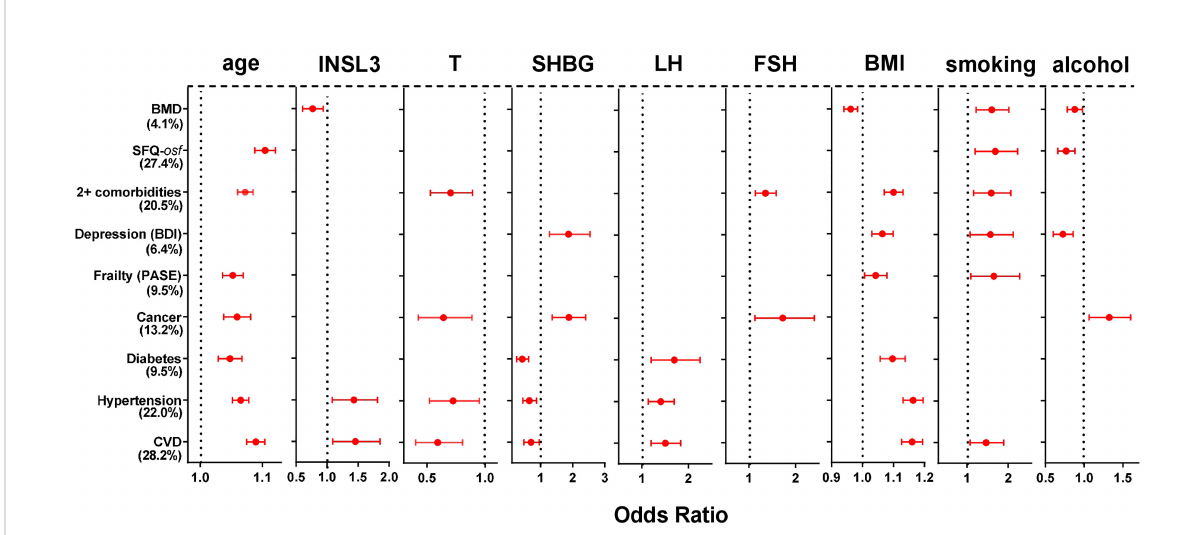
FIGURE 3 Signi fi cant Odds Ratios (OR; mean and 95% con fi dence intervals) calculated from multivariate binomial logistic regressions of the indicated binomial categorical variables from phase 2 representing different morbidities, as indicated on the Y axis, against various hormonal, anthropometric and lifestyle parameters as independent continuous predictors, as indicated, also from phase 2. Signi fi cant OR are indicated in red; non-signi fi cant relationships are excluded (not shown). The estimated variance (percentage, based on the Nagelkerke pseudo-R 2 ) accounted for by the models is indicated in parentheses. BMD and SFQ- osf are expressed as binomial categorical variables, as in the legend to Figure